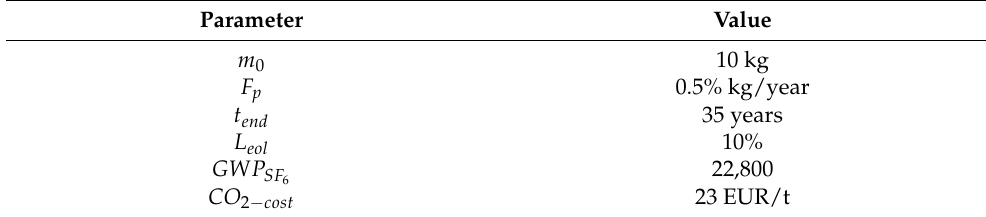
Table 2. Parameters used for the estimation of SF 6 leakage in a new project.